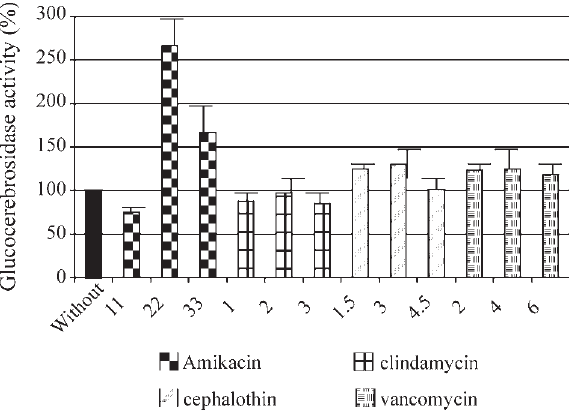
Figure 5 - Effect of antibiotics added to fibroblast cultures on its protein content. The results (mean ±SD) are expressed as % of protein content of cellsthatreceivedantibioticsinrelationtothosewithoutthisdrug(100%). * statistical difference from 100%, p < 0.05.